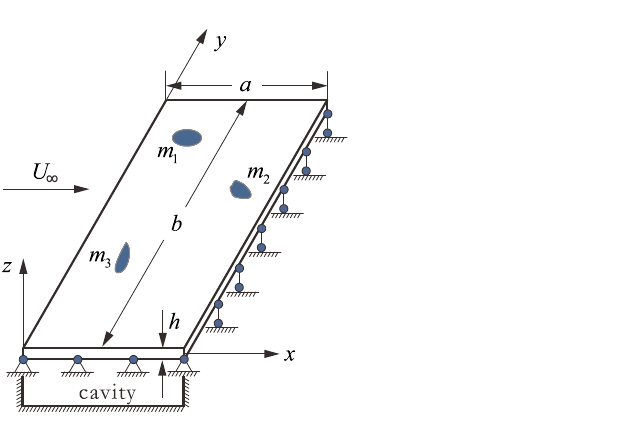
Figure 1. A simply supported panel with three mass attachments in the supersonic airflow.